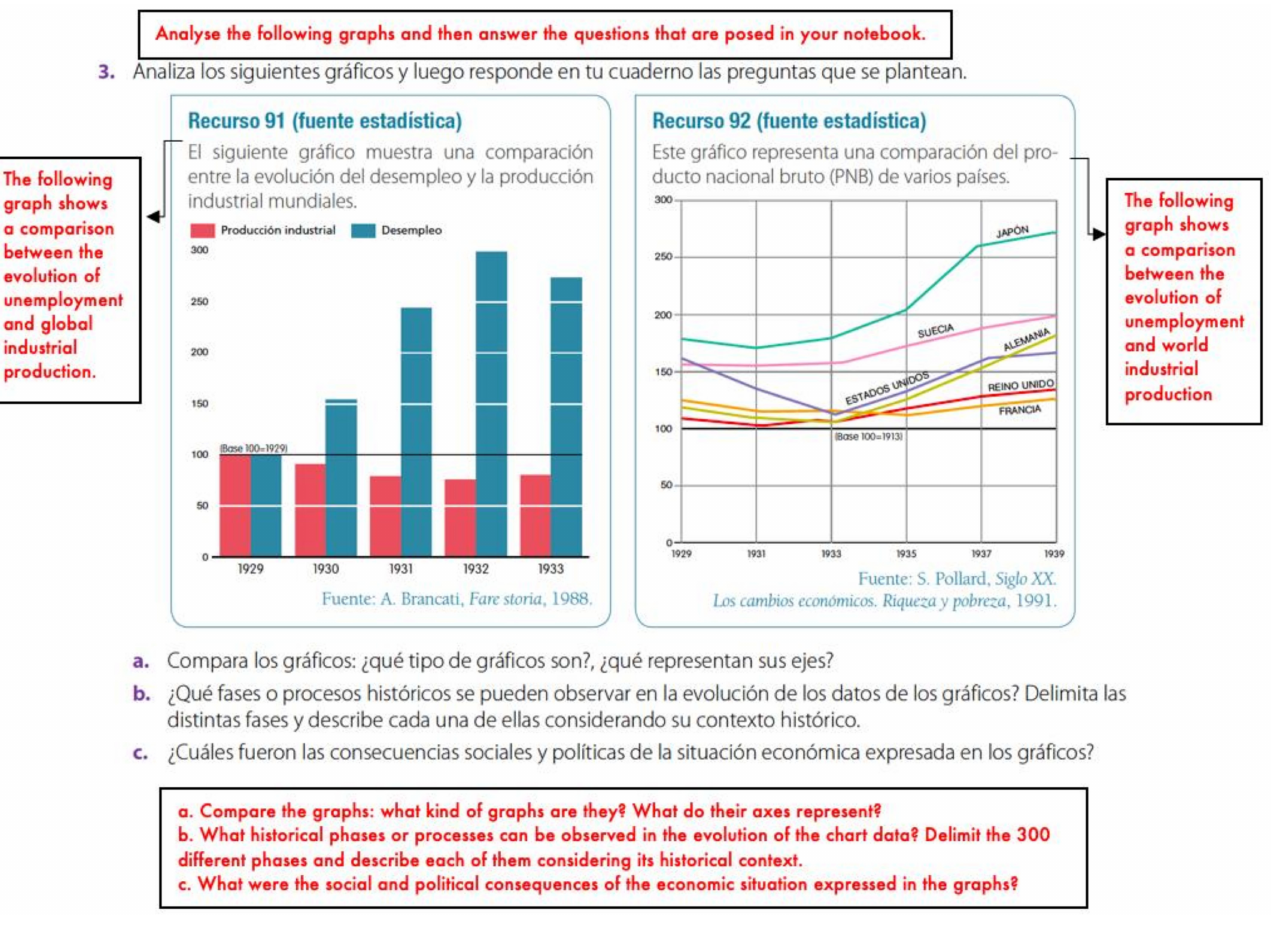
Figure 7. Example of task meaning M3 as a statistical variable (Adapted from [35] (p. 73)).